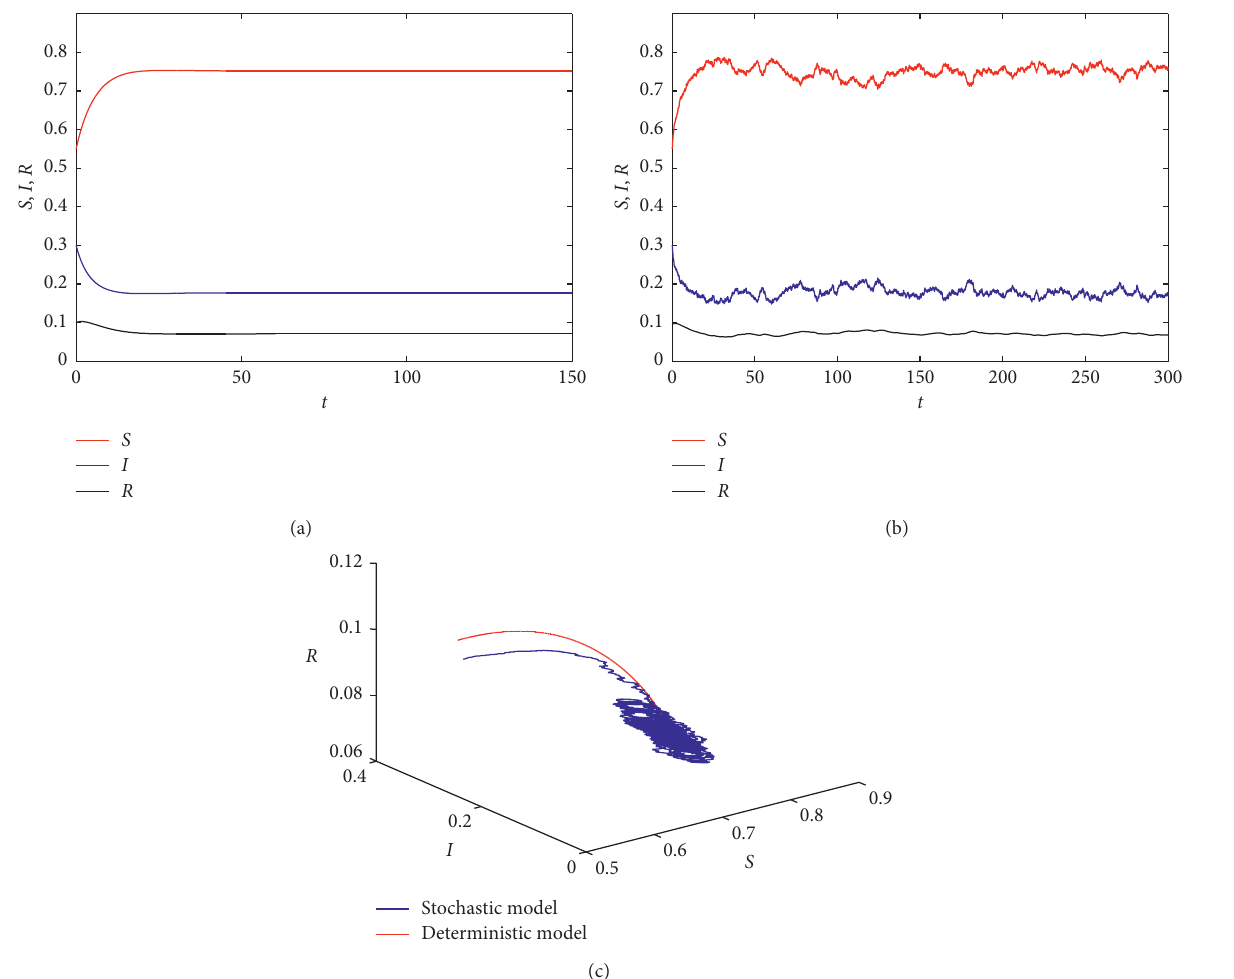
Figure 1: (a) Deterministic system, (b) corresponding stochastic systems of (a), and (c) the phase portrait of (b). (a) σ � 0 . 1 , σ � 0 . σ 1 2